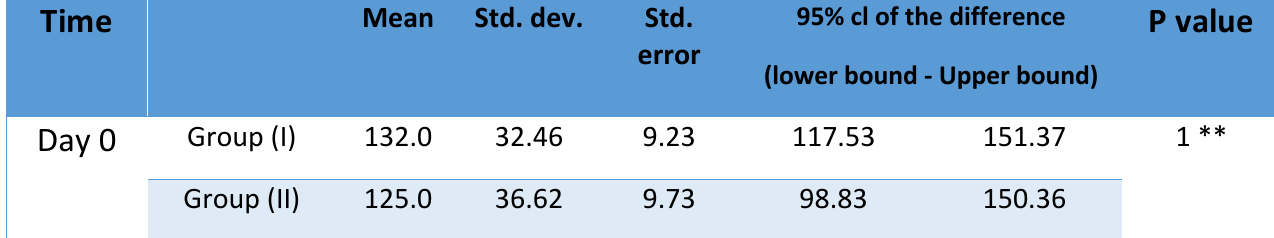
Table 6. Mean values for the wound size index (mm) at all time